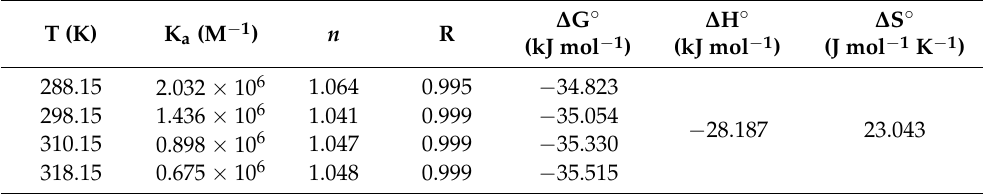
Figure 7. Van’t Hoff plot of HSA-PAZ interaction (R: 0.999). The calculated parameters are shown in Table 2 for different temperatures. The negative ∆ G ◦ values and high K a values indicate a spontaneous and strong interaction between PAZ and HSA. Since both entropy and enthalpy changes contribute to the Gibbs free energy change, the binding interaction can be regarded as both enthalpy- and entropy- driven. Table 2. Binding and thermodynamic parameters for the interaction of HSA with PAZ at differ- ent